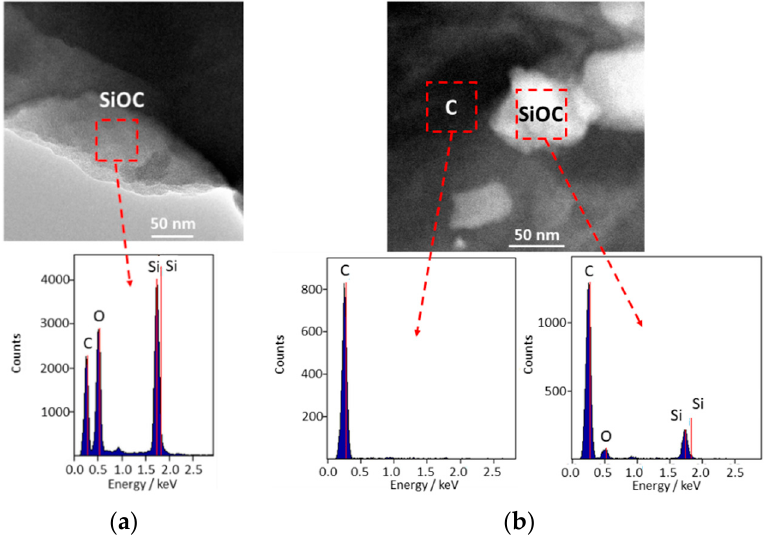
Figure 6. TEM images of: ( a ) SiOC PhTES and ( b ) SiOC PhTES /C10g samples.